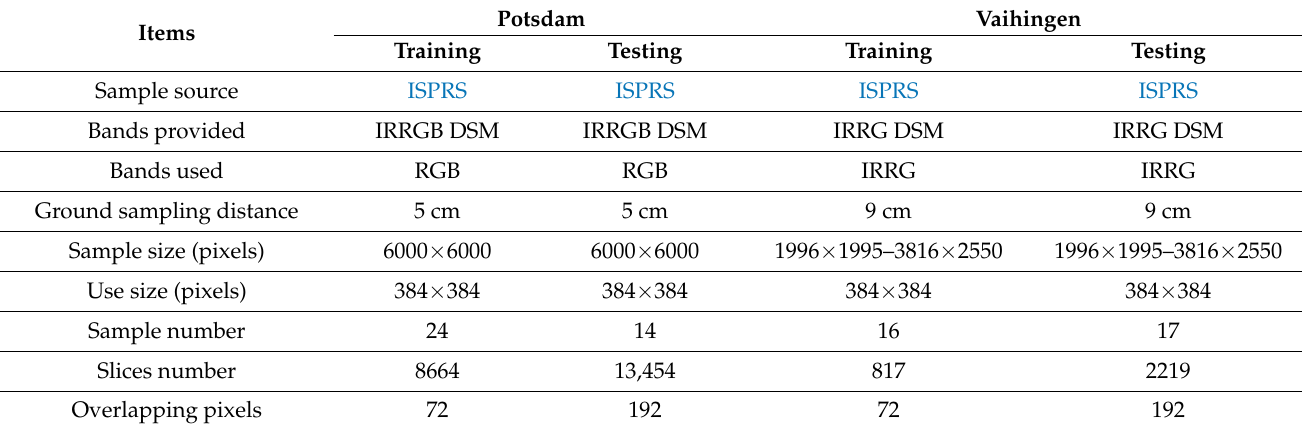
Table 1. Datasets